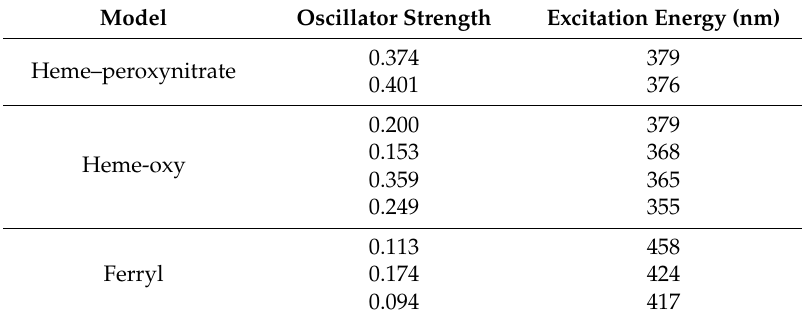
Table 1. Tabulated wavelengths of the main Soret bands in peroxynitrate, oxy and oxo heme models derived from M06-L/6-311g(d,p) TD-DFT calculations. The excitations with oscillator strengths of at least ~0.1 and wavelengths higher than 350 nm are listed. Frontier molecular orbitals involved in the excitations as well as their energies can be found in the supplementary information (Table